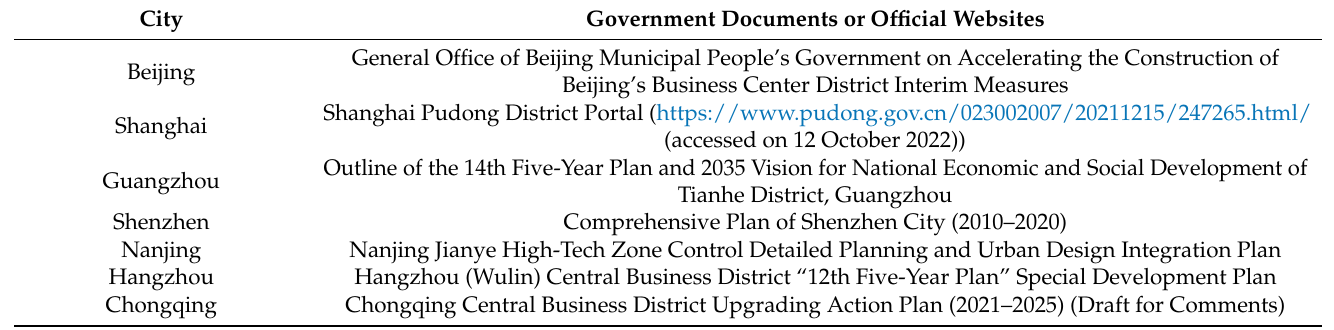
Table 2. The reference list of CBD boundaries for seven Chinese cities.